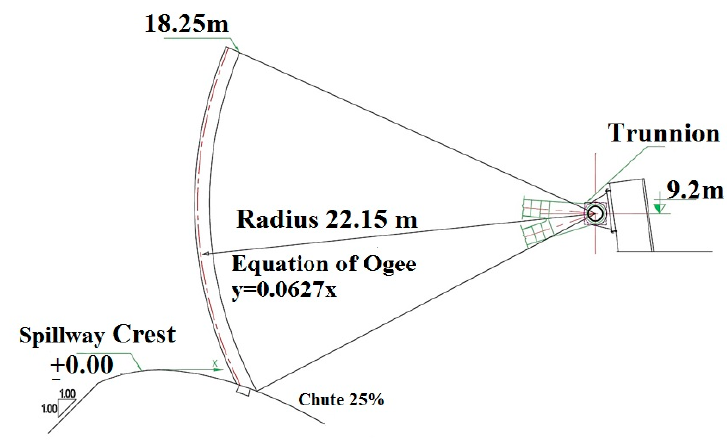
Figure 3. Geometric characteristics of Karkheh Dam’s radial gate spillway (m).